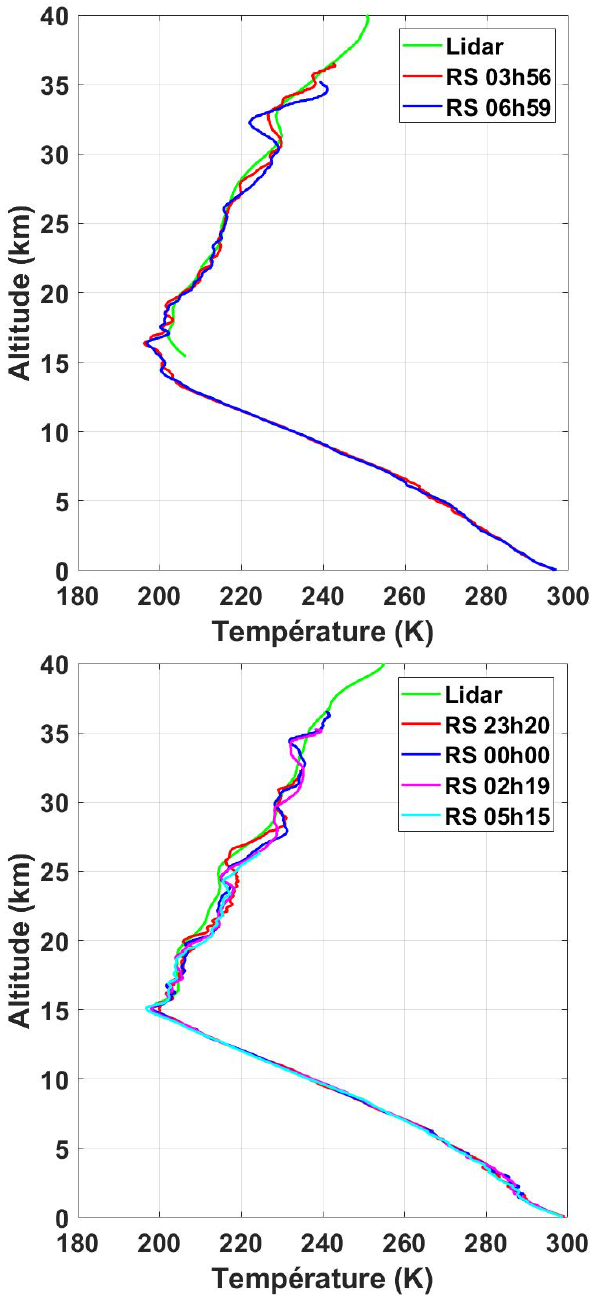
Figure 2. Two examples of temperature profiles from the Monge lidar (green) vibrational Raman channel at 608 nm and locally launched